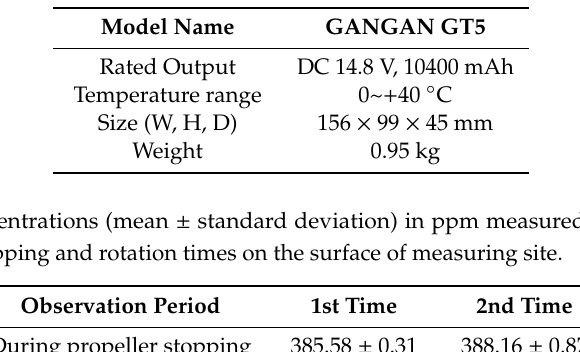
Table A5. Major specifications of the Lithium-ion battery.